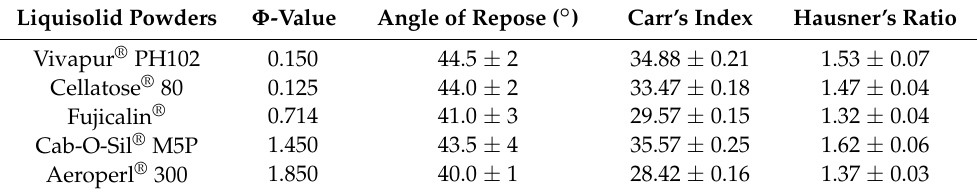
Table 5. Φ -value and micromeritic properties of liquisolid powder ( n = 3).